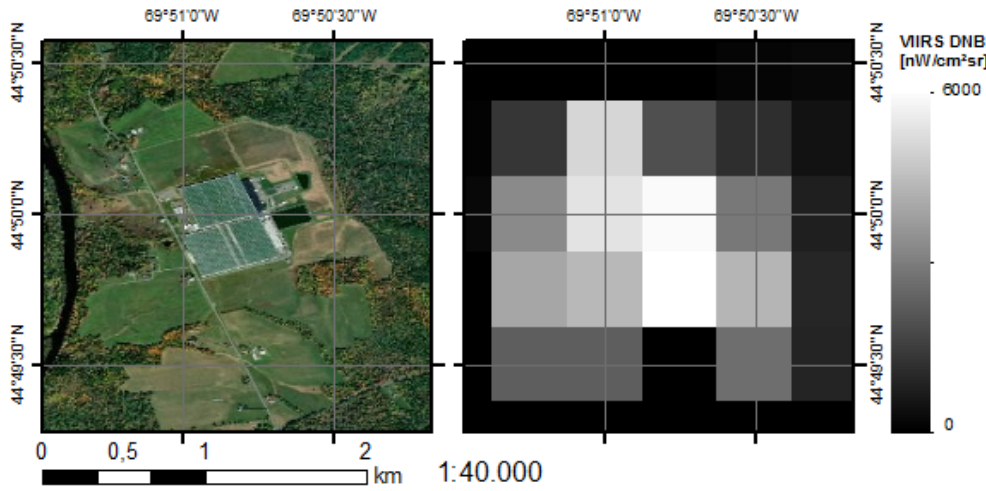
Figure 2. Greenhouse complex in the US state of Maine (44 ◦ 49 (cid:48) 57.7 (cid:48)(cid:48) N, 68 ◦ 50 (cid:48) 52.4 (cid:48)(cid:48) W). The image shows both the extreme brightness of the greenhouse and how the light is not restricted to within a single pixel in the monthly